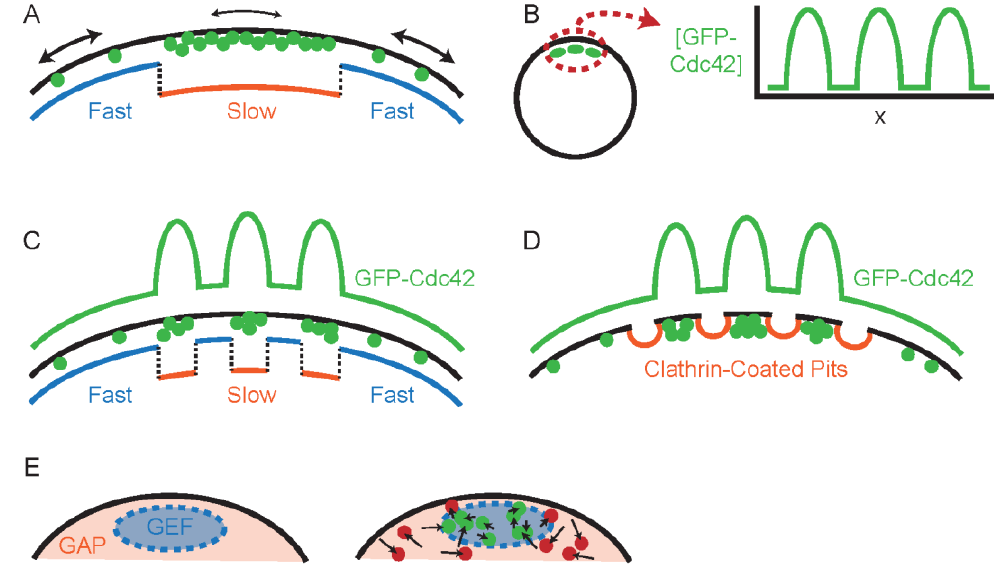
Figure 3. Differential diffusion of Cdc42. ( A ) Location-dependent differential diffusion: zones of fast and slow mobility (blue and orange, respectively) would cause a protein (green) to become concentrated in the slow-diffusion zone. ( B ) GFP-Cdc42 displays patchy localization at polarity sites. ( C ) Patchy localization could be explained by alternating zones of slow and fast mobility. ( D ) Patchy localization of GFP-Cdc42 could also be explained by exclusion of GFP-Cdc42 from endocytic sites (clathrin-coated pits). ( E ) Differential diffusion of GTP-Cdc42 and GDP-Cdc42. Localized GEF activity (blue) and uniform GAP activity (orange) would lead to local activation of Cdc42 in the GEF zone. If GTP-Cdc42 (green) diffuses less than GDP-Cdc42 (red), then Cdc42 accumulates in the GEF zone. Arrows indicate high mobility of GDP-Cdc42 relative to GTP-Cdc42.